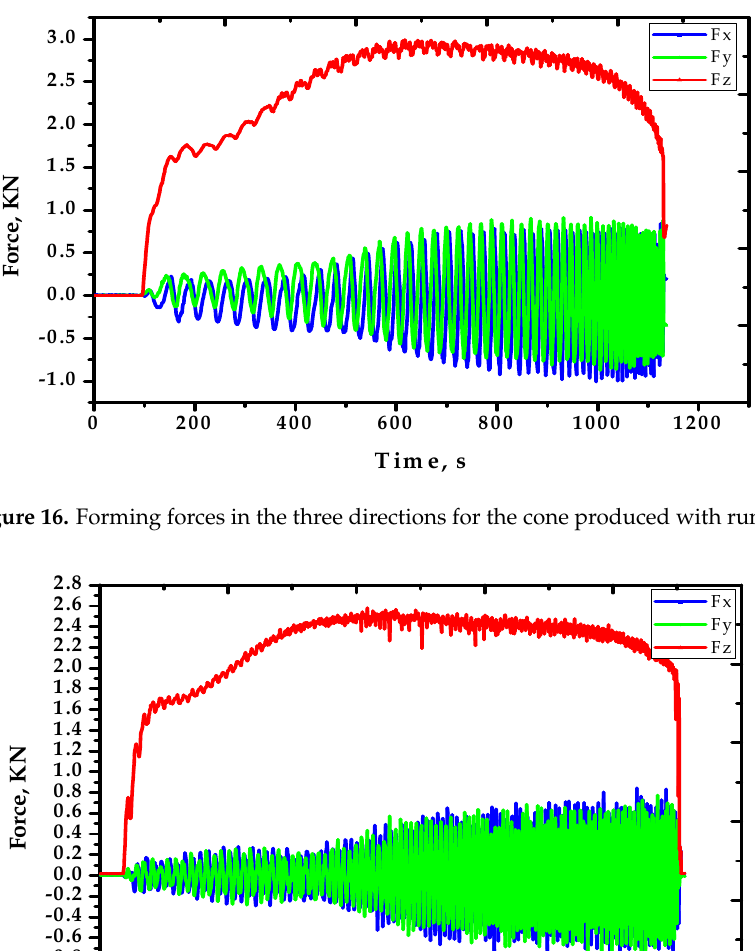
Figure 15. Forming forces in the three directions for the cone produced with run 6, ( F z-p min. = 2.4513 kN).